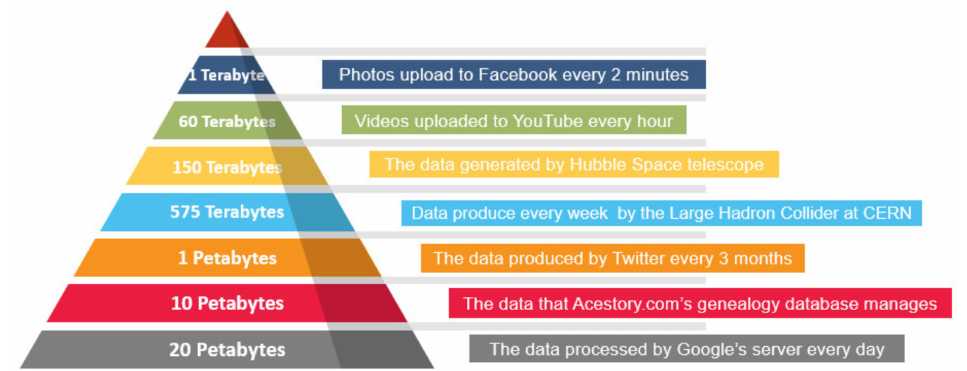
Figure 1. Understanding the data